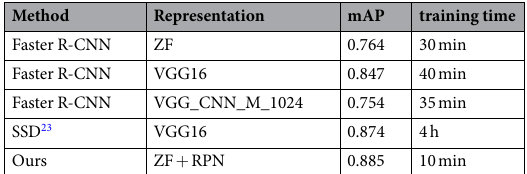
Table 2. Comparison of our deep-learning architecture with other methods on the same dataset, where Faster R-CNN means faster region-based convolutional neural network, and SSD means single shot